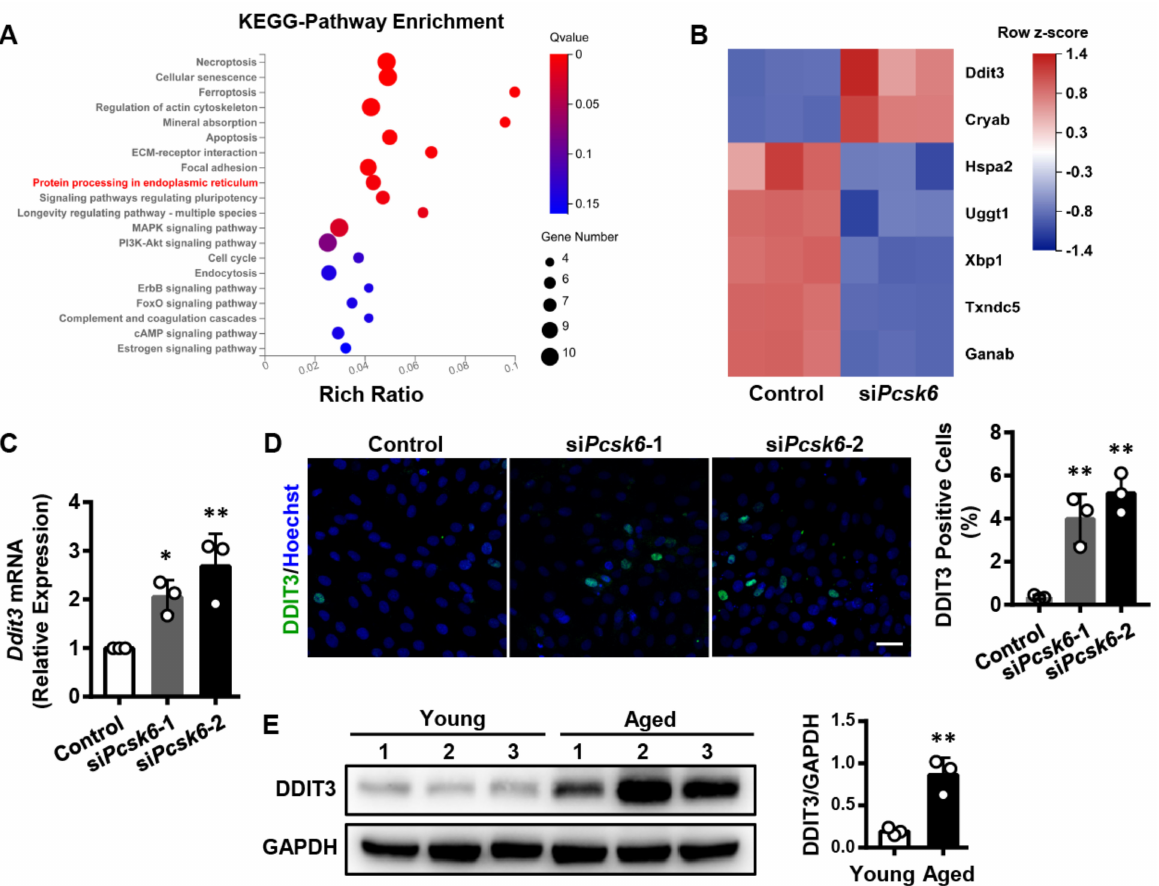
Figure 6. Identification of DEGs by pathway analysis in H9c2 cells with Pcsk6 knockdown. ( A ) KEGG enrichment analysis of DEGs in signaling pathways. Y -axis denotes pathway and X -axis denotes rich ratio. The 20 most significantly changed pathways are shown. The targeted pathway in the study is highlighted with red color. The color intensity and size of bubbles indicate Q value and number of genes, respectively. ( B ) A heat map for DEGs in si Pcsk6 -transfected H9c2 cells. The 7 most significant DEGs in the protein processing in the ER pathway. Red and blue colors represent up- and down-regulated genes, respectively. ( C ) qPCR analysis of Ddit3 mRNA expression in si Pcsk6 - transfected H9c2 cells. ( D ) Immunofluorescent staining for DDIT3 (green) and nuclei (blue) in si Pcsk6 -transfected H9c2 cells. Scale bar: 40 µ m. Percentages of DDIT3 positive cells were